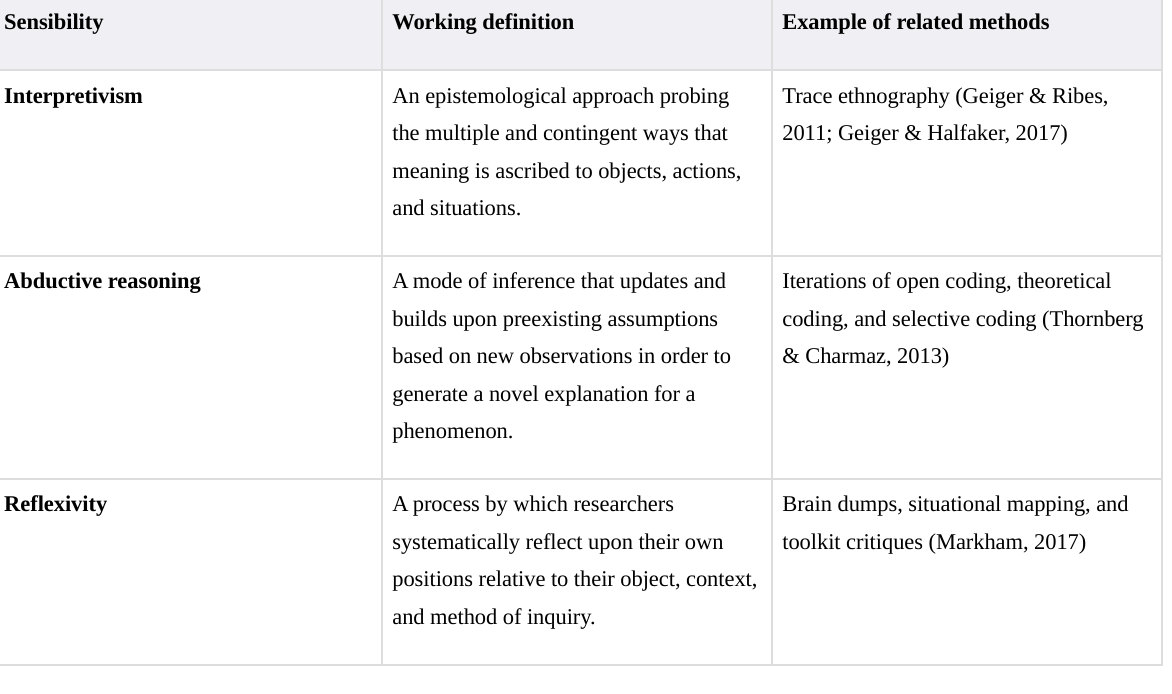
Table 1. Summary of qualitative